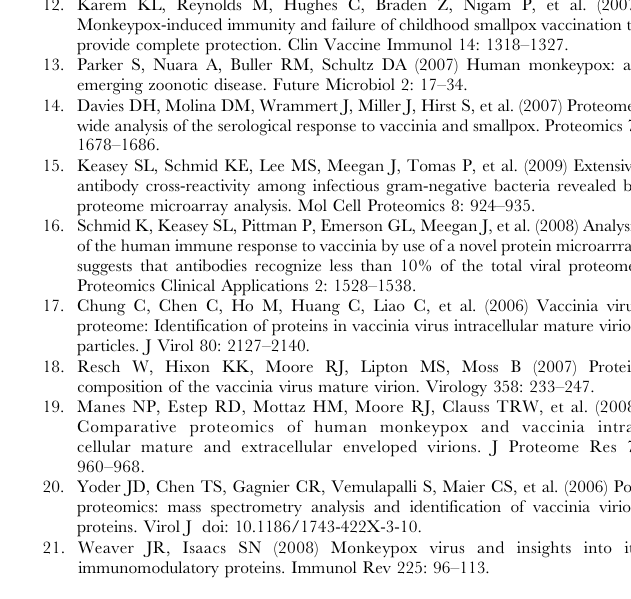
Table S1 Proteome Microarray Data (Relative Fluores- cent Units).